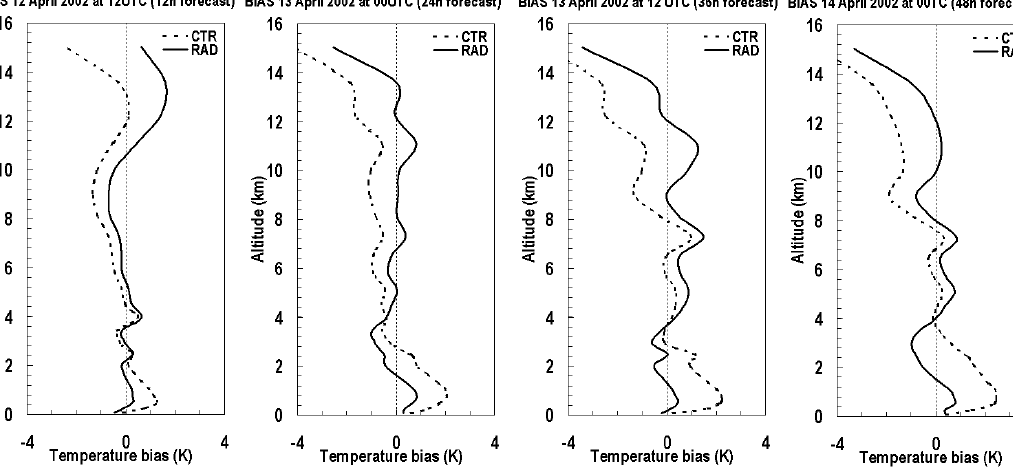
Fig. 4. Vertical profiles of the atmospheric temperature bias between a control run (CTR) without and a full run (RAD) with SW and LW radiative interaction of dust aerosols. Profiles are over an area most strongly affected by Saharan dust (30–45 ◦ N, 0–20 ◦ E) for the 12, 24, 38, and 48h forecasts of the 00:00 UTC forecast cycle on 12 April 2002 (Adopted from Pérez et al.,